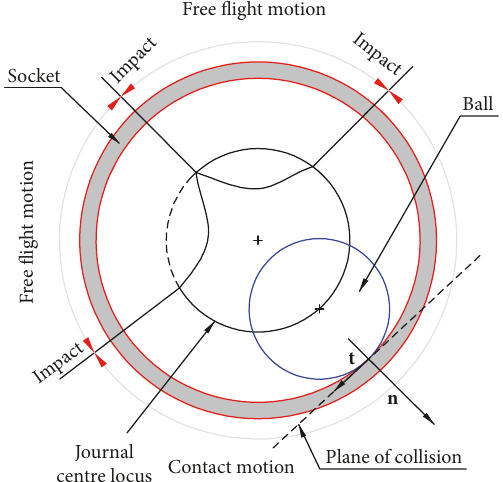
Figure 3: Configuration of spherical joint with